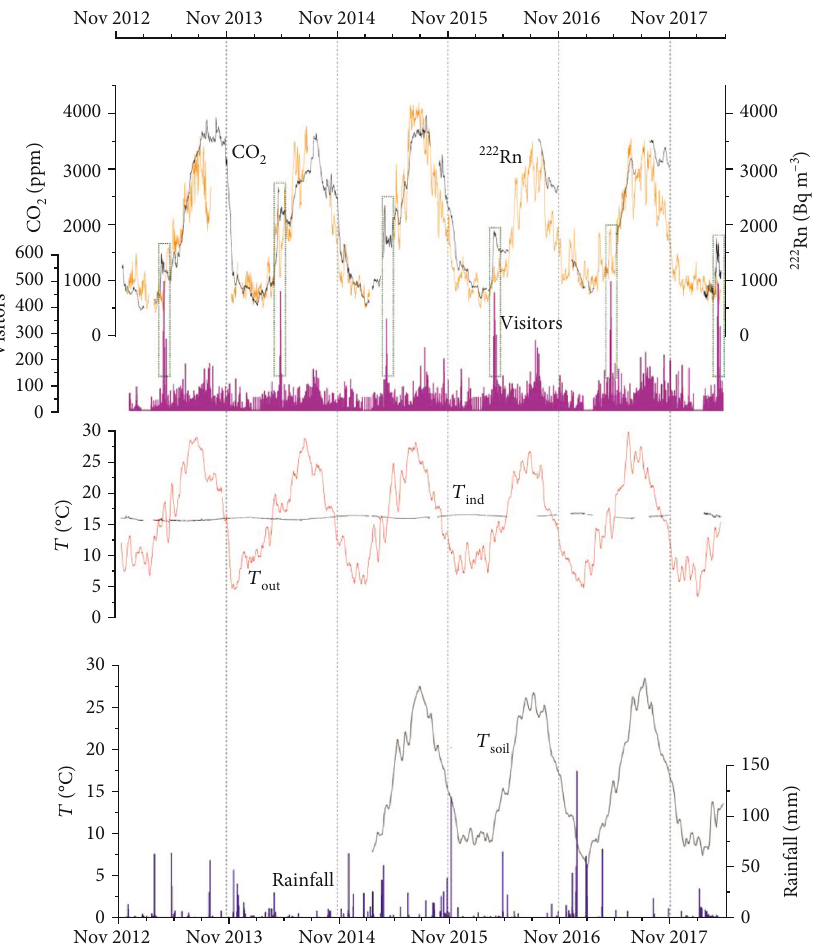
Figure 3: Temporal evolution of microclimatic variables in Rull Cave for the period December 2012-April 2018. Measured variables are as follows: CO (ppm) and 222 Rn (Bq m -3 ) concentrations; outdoor ( T out ), cave ( T ind ), and soil temperature ( T soil ) ( ° C); visitors; and daily 2 rainfall (mm). The presence of visitors during Easter holiday for each year of the time series is marked with rectangles in dashed